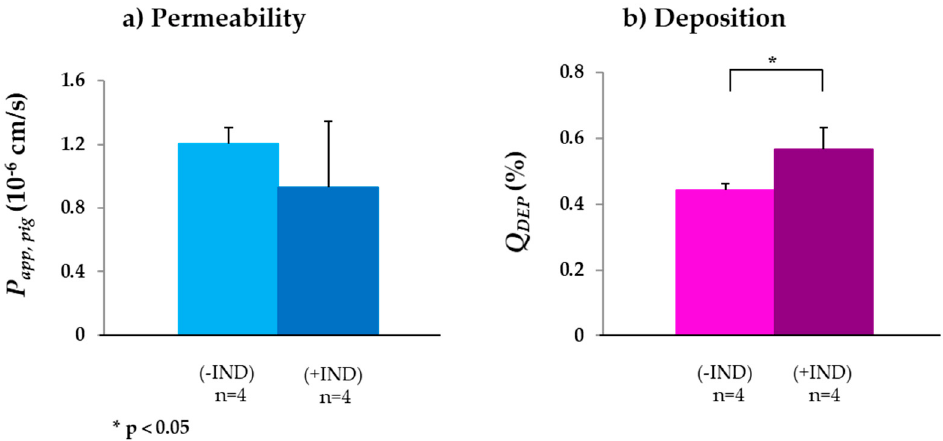
Figure 3. ( a ) P app,pig and ( b ) Q DEP of valsartan in absence ( − IND) and presence ( + IND) of the MRP2 inhibitor indomethacin (IND) (mean ± SD; n = number of replicates).